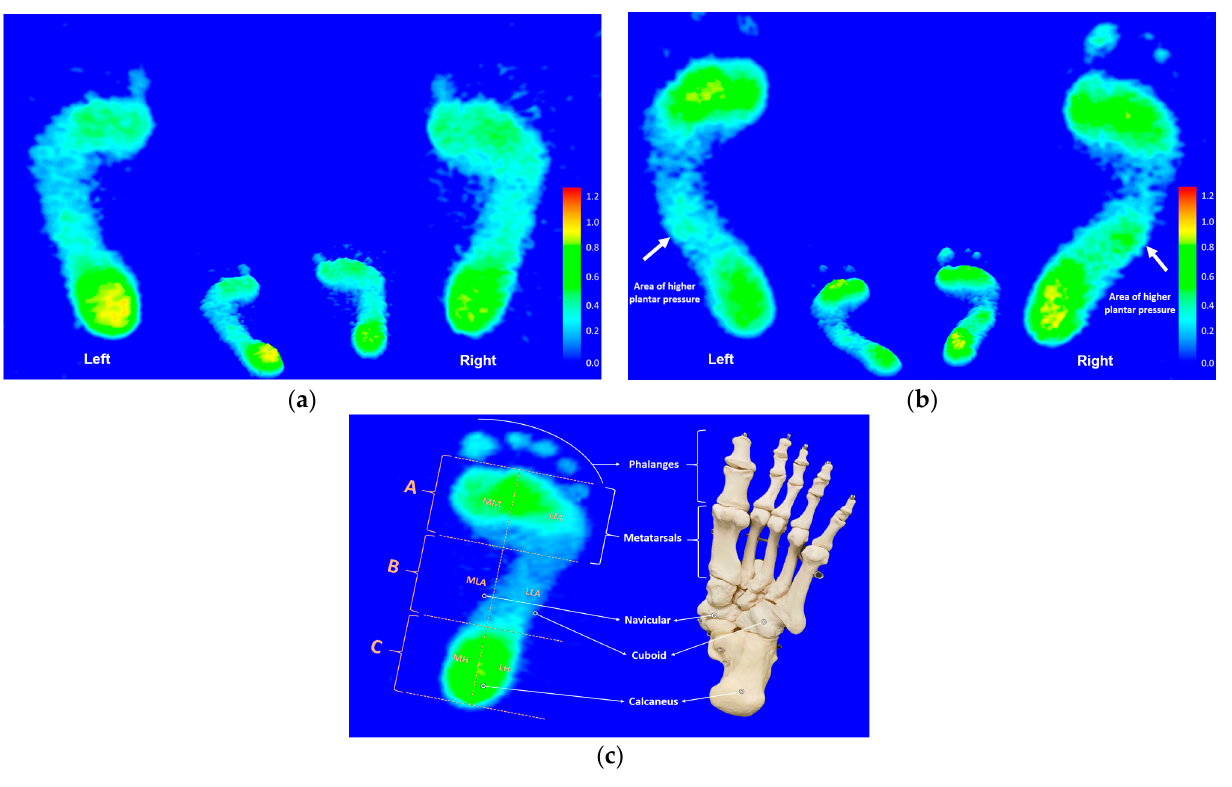
Figure 1. Static footprint image features of the representative participant in the ( a ) recreational group and the ( b ) elite group. Illustration ( c ) is the color footprint image and the corresponding foot anatomical structure model. White arrows indicate the areas of higher plantar pressure.